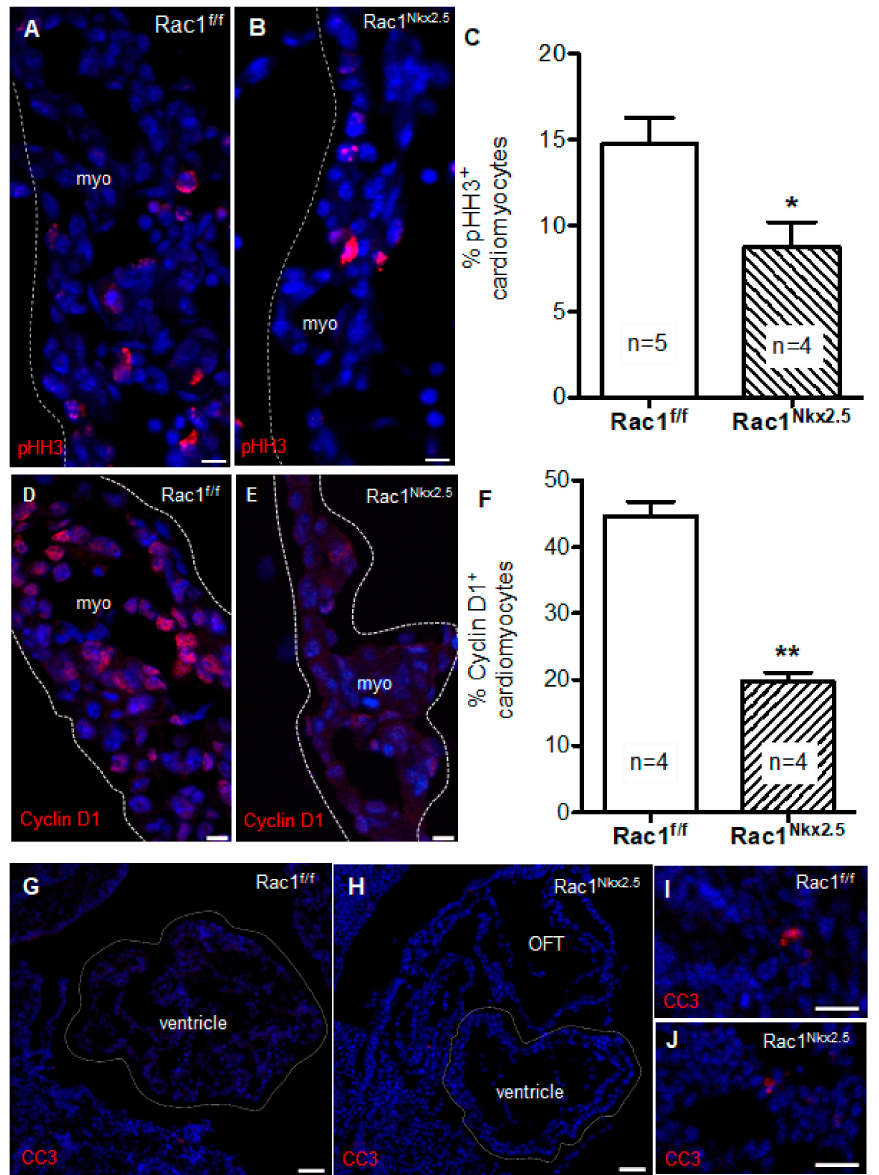
Figure 7. Decreased proliferation rate in Rac1 Nkx2.5 hearts. Phospho-histone H3 (pHH3) immunos- taining to mark proliferating cells undergoing mitosis in ventricular myocardium (myo) of E9.5 Rac1 Nkx2.5 and Rac1 f/f hearts ( A , B ). Proliferation rate was significantly decreased in E9.5 Rac1 Nkx2.5 ventricular myocardium compared to littermate controls ( C ). Cyclin D1 immunostaining in E9.5 Rac1 f/f and Rac1 Nkx2.5 ventricular myocardium marked cell progression through G1 ( D , E ). Cyclin D1 expression was significantly decreased in E9.5 Rac1 Nkx2.5 ventricular myocardium compared to litter- mate controls ( F ). Cleaved caspase-3 (CC3) immunostaining to mark apoptotic cells in ventricular myocardium of E9.5 Rac1 Nkx2.5 and Rac1 f/f hearts. No apoptosis was detected in E9.5 Rac1 Nkx2.5 and Rac1 f/f ventricular myocardium ( G , H ). Apoptotic cells were detected in tissues outside of the heart in Rac1 f/f and Rac1 Nkx2.5 embryos ( I , J ). * p < 0.05, ** p < 0.01 by unpaired Student’s t -test. Scale bars: 10 µ m ( A , B ), 50 µ m ( D – G